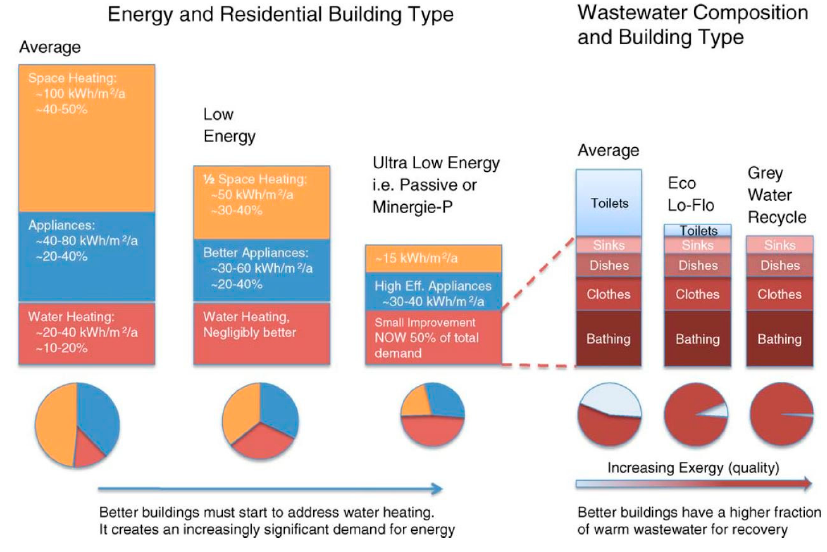
Figure 1. Distribution of energy consumption in buildings [6].